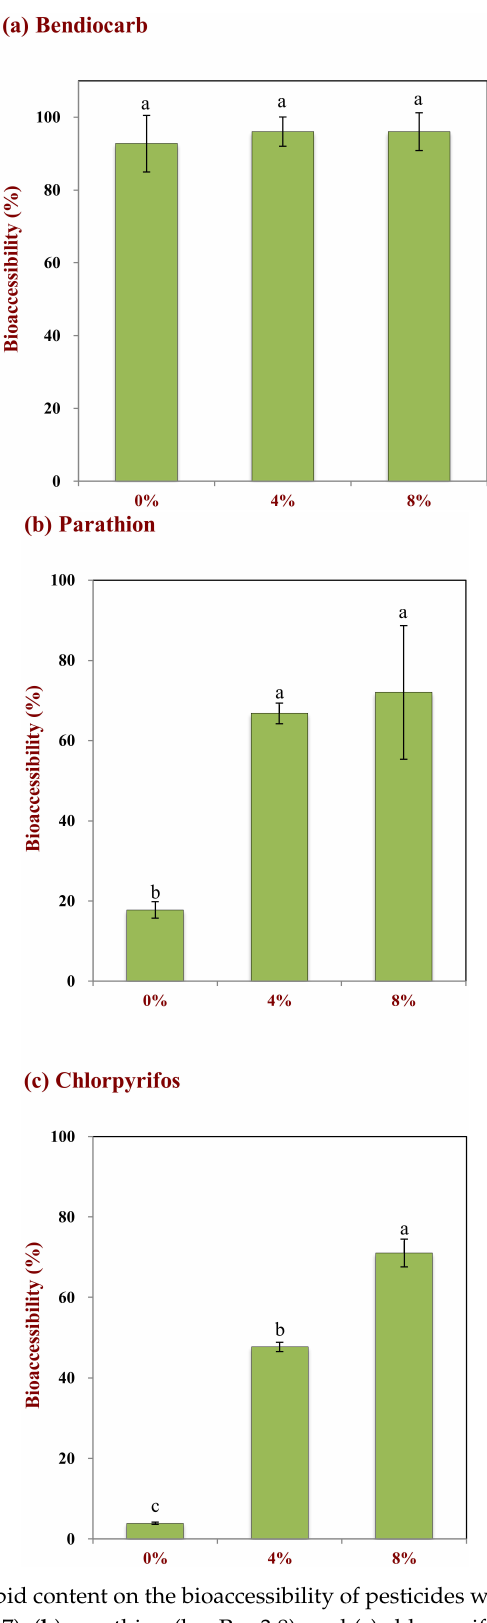
Figure 6. Impact of the lipid content on the bioaccessibility of pesticides with di ff erent Log P values: ( a ) Bendiocarb (log P = 1.7), ( b ) parathion (log P = 3.8), and ( c ) chlorpyrifos (Log P = 5.3). Samples designated with di ff erent capital letters ( a , b , c ) were significantly di ff erent (Duncan, p < 0.05) when compared between di ff erent lipid